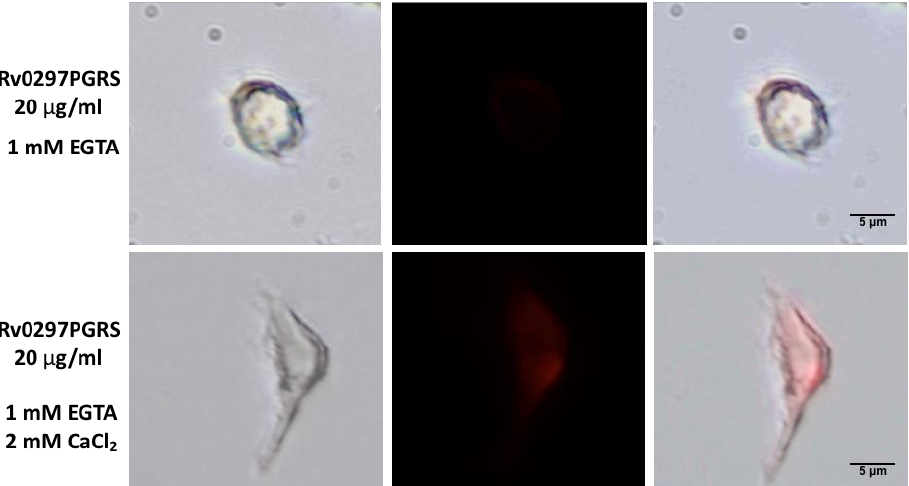
Figure 5. In vitro binding of Rv0297 PGRS with TLR4 of macrophages in the presence of Ca 2+ ions. RAW 264.7 cells incubated with recombinant Rv0297PGRS protein in complete DMEM (consisting Ca 2+ ions) for 2 h and stained with anti-Rv0297PGRS sera (Panel 2). Untreated cells were used as negative control (Panel 1). Calcium was removed from medium using 0.5 mM and 1 mM EGTA (third and fifth panel, respectively), followed by incubation with rRv0297PGRS protein and staining with anti-Rv0297PGRS sera. Ca 2+ levels were replenished in the culture medium using 2mM CaCl 2 . Alexa Fluor 555 fluorescent images were captured for TLR4 and Rv0297PGRS interaction and merged images were created (right column). Red colored puncta formation over RAW264.7 cell surfaces depicts the interaction of Rv0297PGRS with TLR4 of macrophages (2nd, 4th and 6th panel). The puncta formation (or interacting complexes) was reduced in case of using EGTA (3rd and 5th panel). Magnification, X